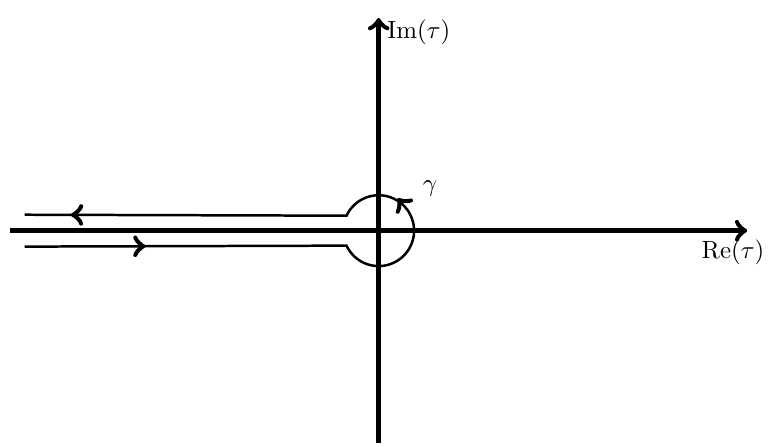
Figure 1 . The Hankel contour used in eq.